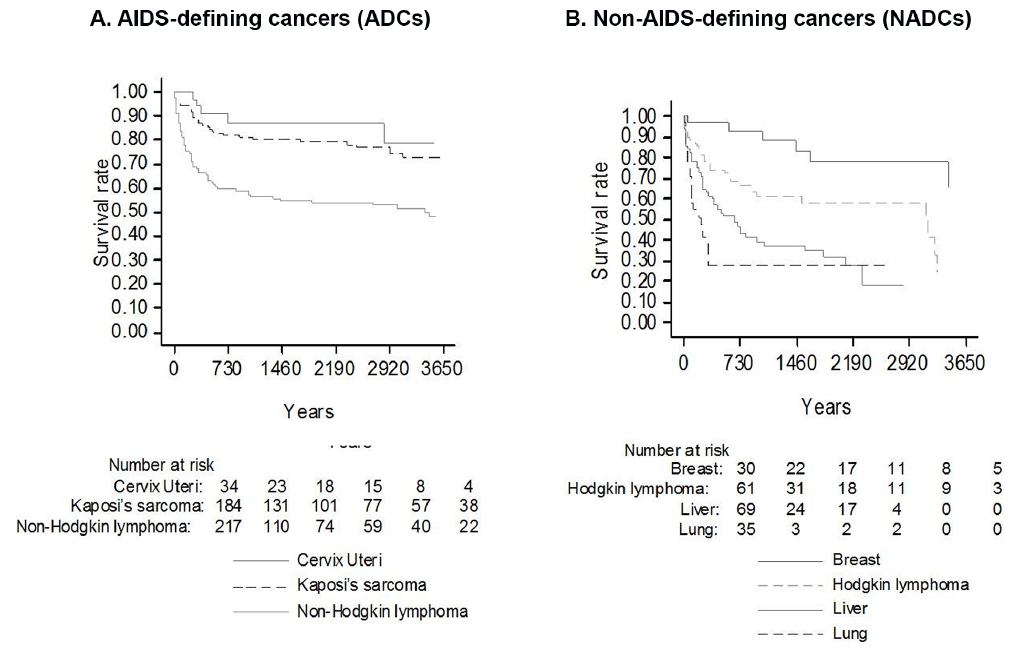
Figure 2. Survival curves according to specific cancer types. Panel (A) Survival probabilities according to AIDS-defining cancer (ADC) diagnosis. Overall, the median survival time from diagnosis of all ADC was 3.4 years; more specifically, the median survival time of NHL was 2.1 years, Kaposi sarcoma 4.7 years, and cervical cancer 5.1 years. Panel (B) Survival probabilities according to non-AIDS-defining cancer (NADC) diagnosis. The overall median survival time of NADC was 1.6 years; more specifically, the median survival time of liver cancer was 441 days, lung cancer 113 days, breast cancer 1624 days, and Hodgkin lymphoma 795 days.